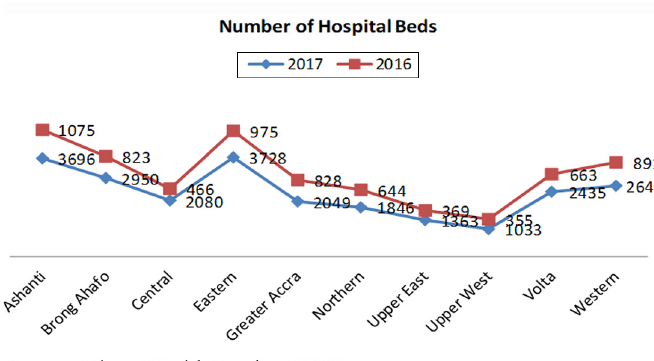
Figure A2. Number of hospital beds by